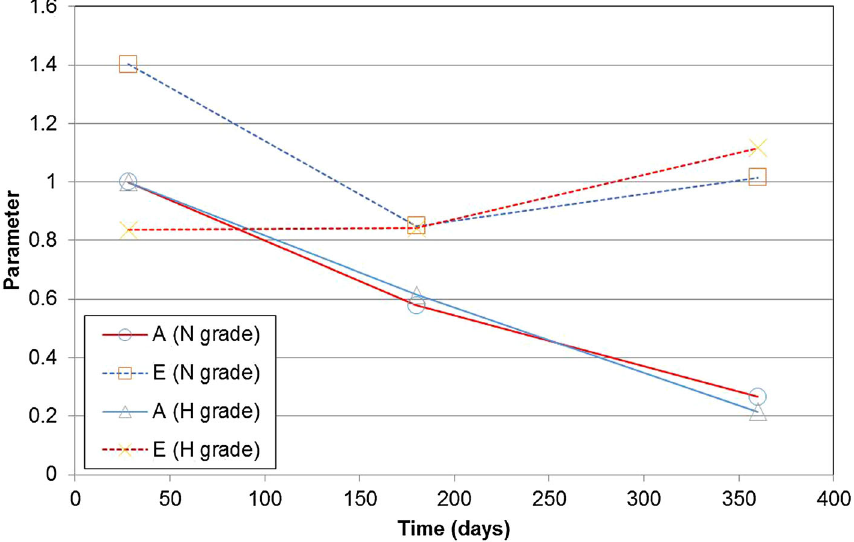
Fig. 7 Regression analysis on parameters ( A and E